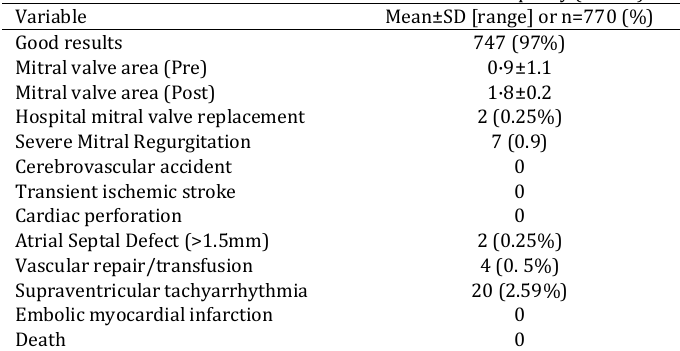
Table2. Immediate results after Percutaneous Mitral Valvuloplasty (n=770) Variable Mean±SD [range] or n=770 (%) Good results 747 (97%) Mitral valve area (Pre) 0·9±1.1 Mitral valve area